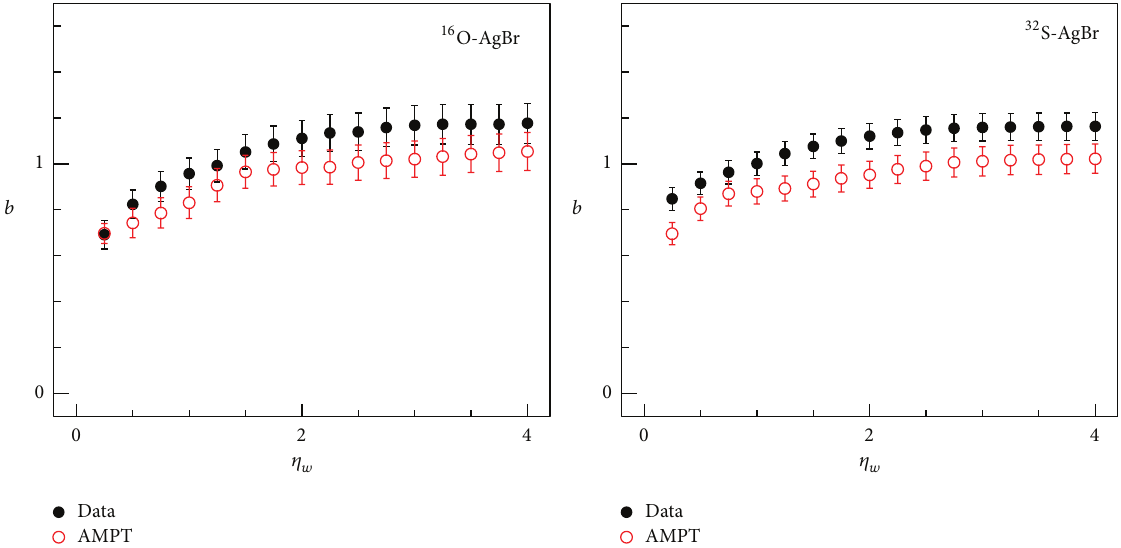
Figure 5: Dependence of 𝑏 on separation gap, 𝜂 𝑤 for 16 O- and 32 S-AgBr